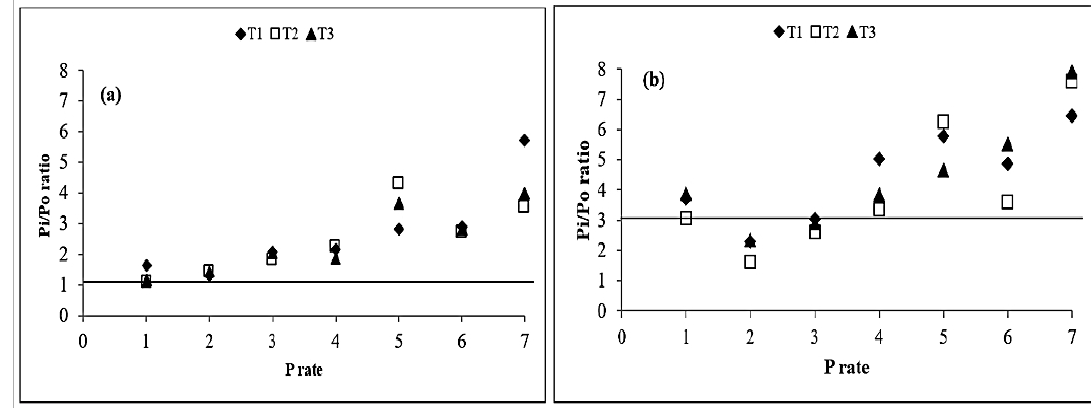
Figure 6. Pi/Po ratio for soil 1 ( a ) and soil 2 ( b ). P rates (mg/L), 1: 2.36, 2: 6.77, 3: 11.08, 4: 15.92, 5: 21.96, Figure 6. Pi / Po ratio for soil 1 ( a ) and soil 2 ( b ). P rates (mg / L), 1: 2.36, 2: 6.77, 3: 11.08, 4: 15.92, 5: 6: 40.59, 7: 88.88. Horizontal lines indicate the initial Pi/Po values (1.15 and 3 for soils 1 and 2 21.96, 6: 40.59, 7: 88.88. Horizontal lines indicate the initial Pi / Po values (1.15 and 3 for soils 1 and 2 respectively).